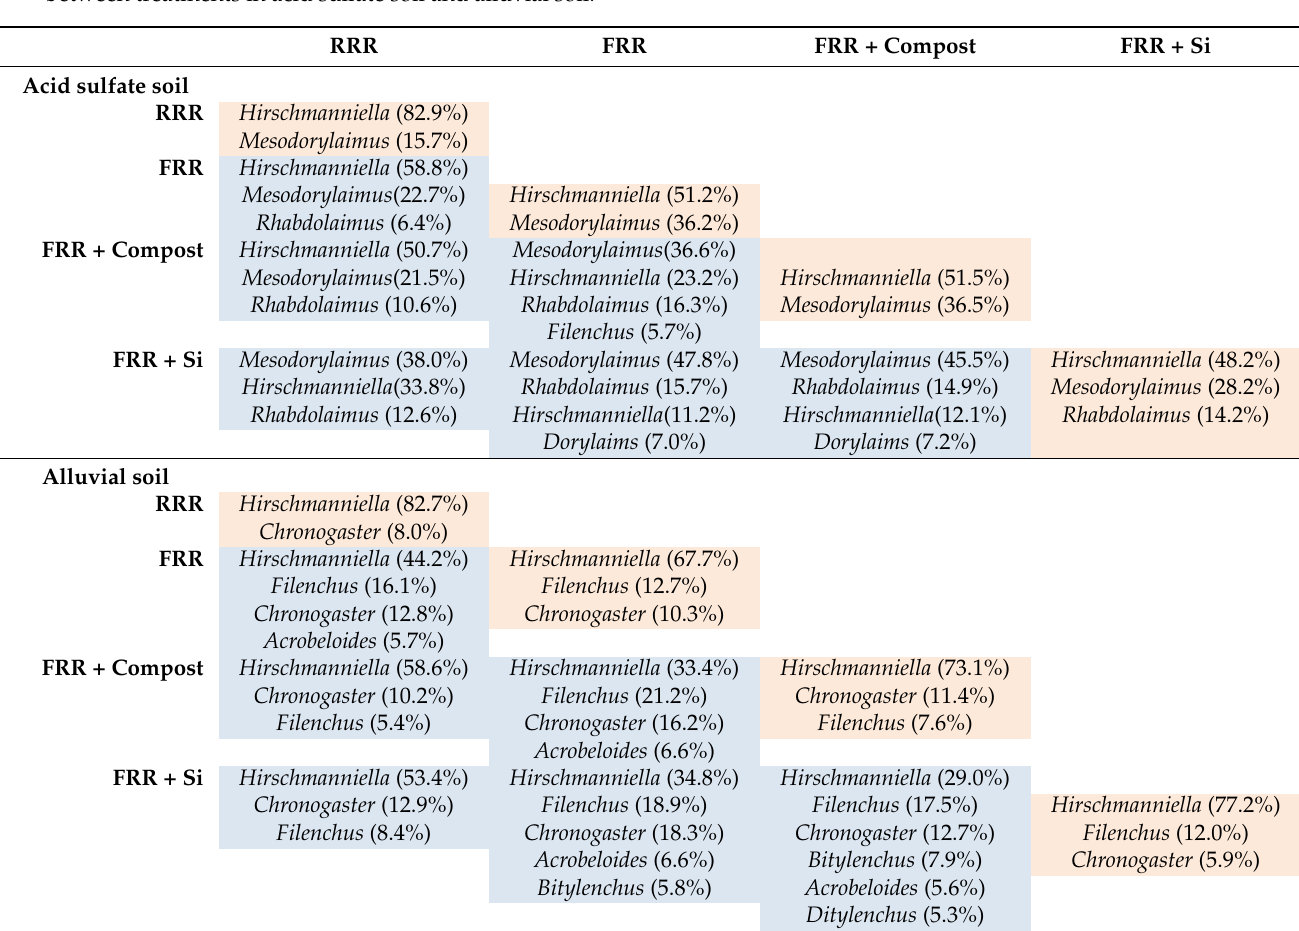
Table 3. SIMPER analysis based on nematode abundance for analyzing the similarity within treatment and dissimilarity between treatments in acid sulfate soil and alluvial soil.